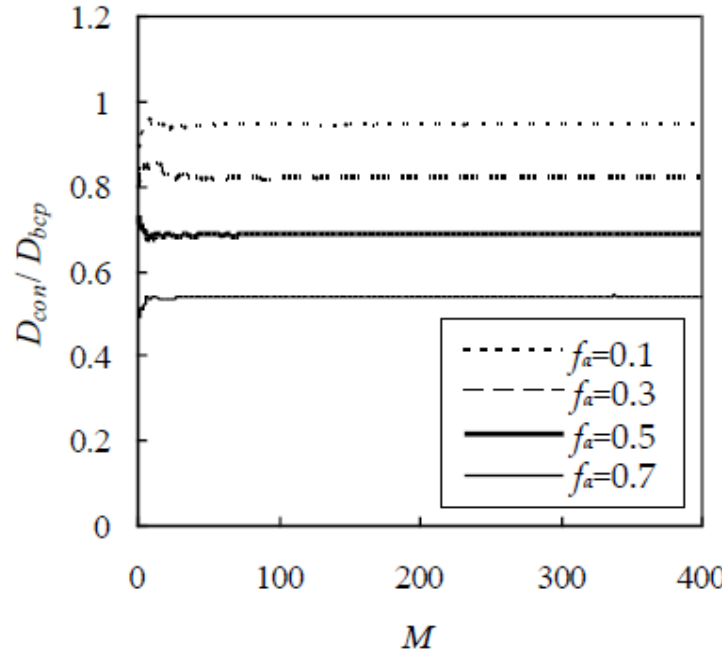
Figure 11. Effect of M on chloride diffusivity of concrete. Figure 11. E ff ect of M on chloride di ff usivity of